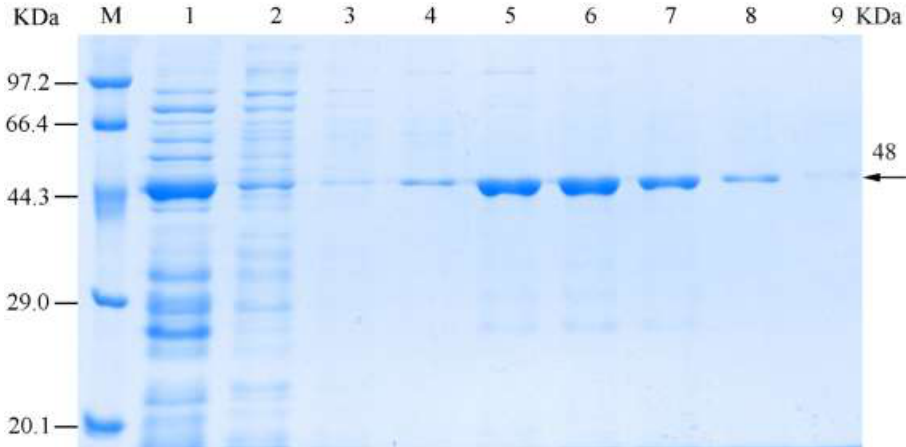
Figure 8. Purification and detection of recombinant protein M: Protein marker (low molecular weight